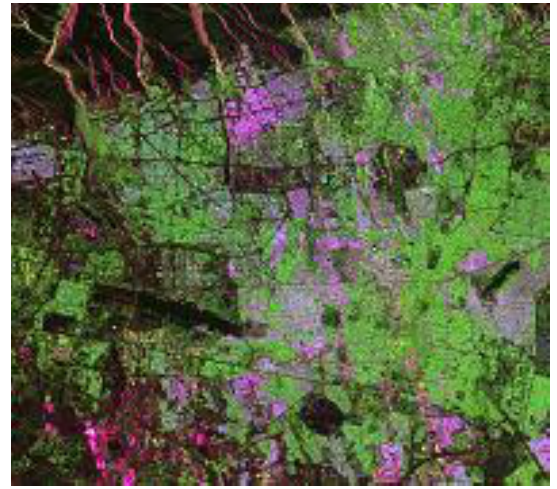
Figure 2. The colour composition (HHR HVG VVB) image of ALOS/PALSAR (mountainous area in the northwest of image affected by layover was masked)